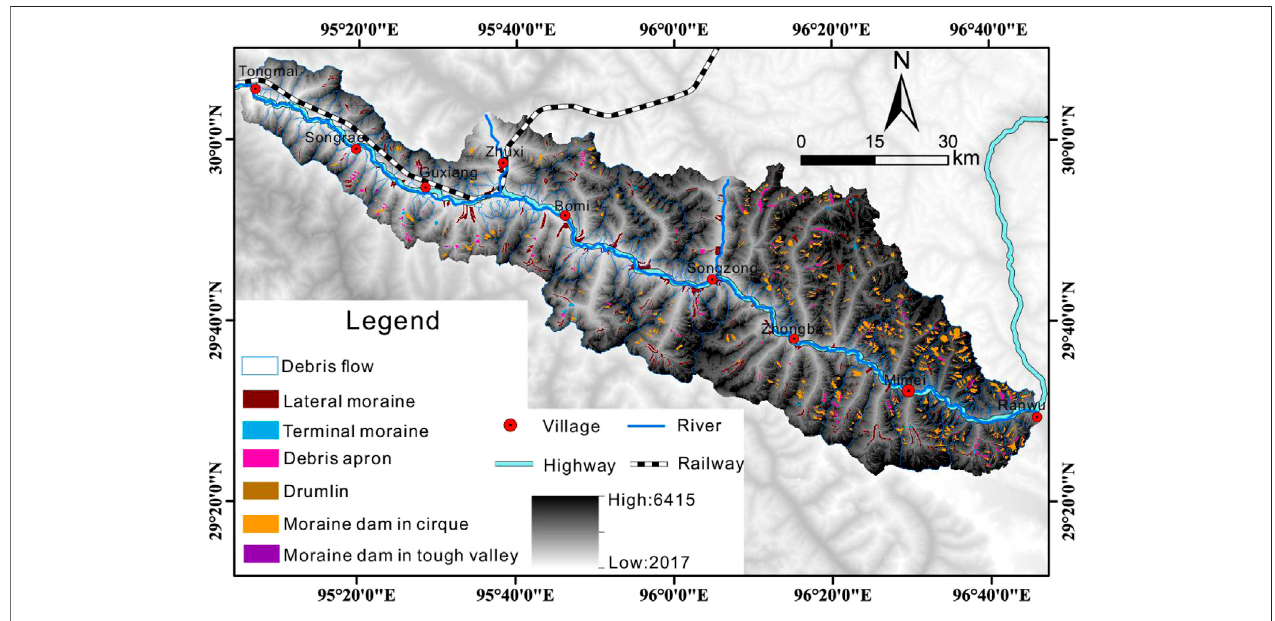
FIGURE 8 | The moraine distribution map in study